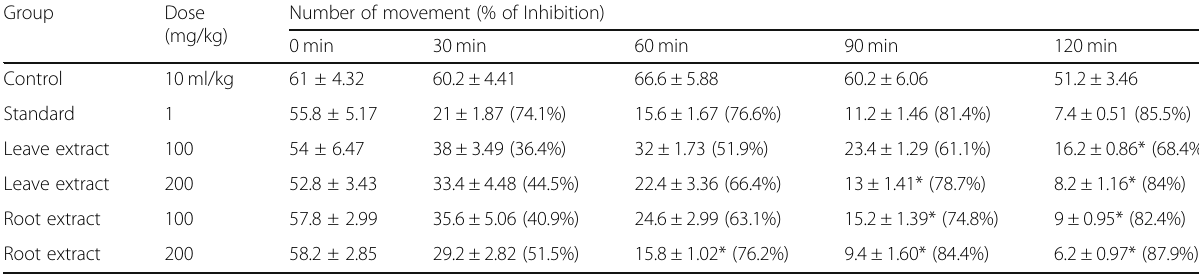
Table 4 Data of CNS depressant activity test of C. turgida extracts by open field method